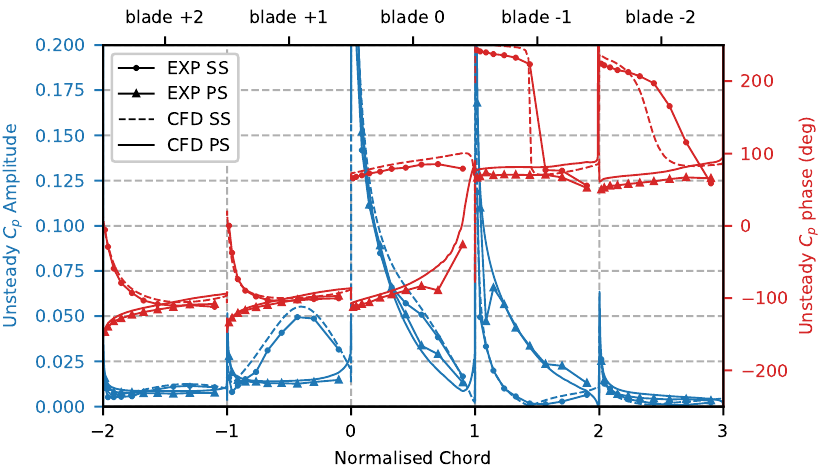
Figure 10. Validation of the unsteady mid-span blade surface pressure coefficient— k = 0.4, x / c = 1, φ =